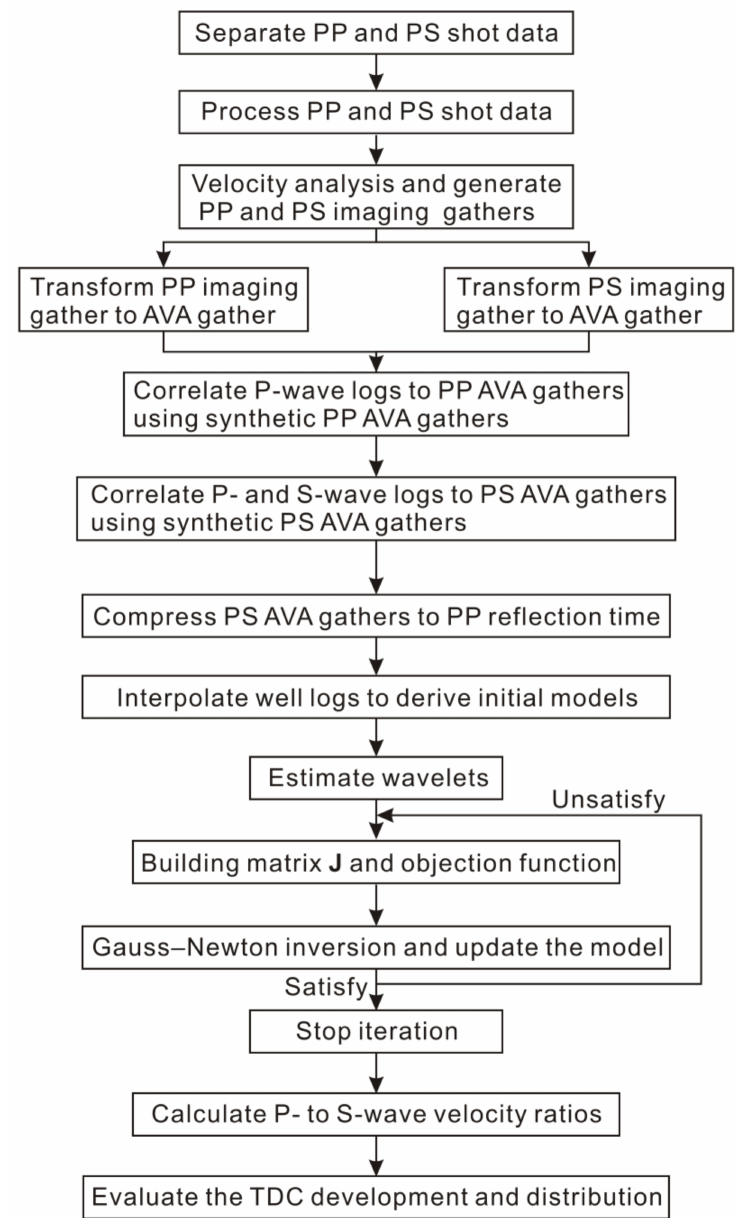
Figure 3. Procedure of the TDC detection using model-based joint PP and PS AVA